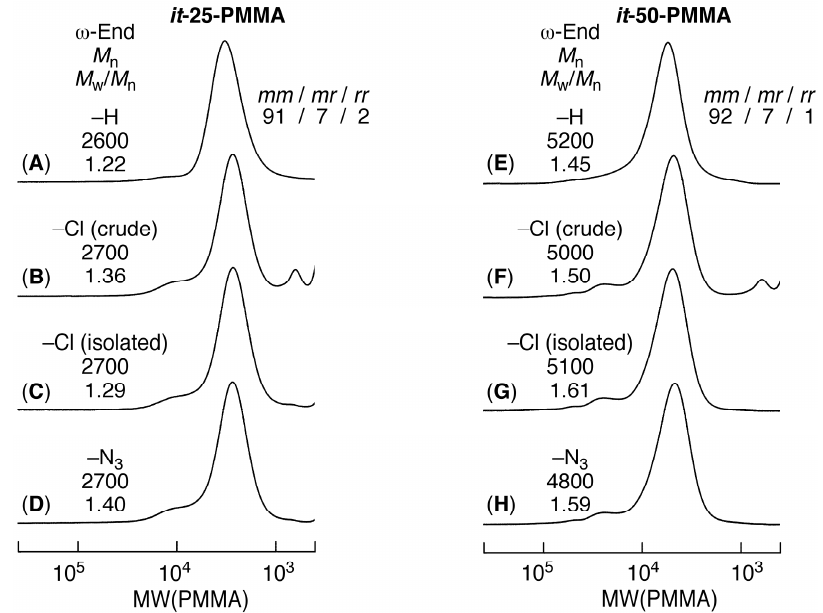
Figure 1. Size-exclusion chromatography (SEC) curves of a series of it - poly(methyl methacrylate)s (PMMAs) (( A – D ): it -25, ( E – H ): it -50) obtained in isotactic anionic polymerization of Methyl methacrylate (MMA) with t -BuMgBr in toluene at − 78 °C and subsequent procedures: ( A , E ) Quenching the polymerization ([M] 0 /[ t -BuMgBr] 0 = 1350/54 or 1350/27 mM) with acidic methanol; ( B , F ) Quenching the polymerization with CCl 4 /DBU ([M] 0 /[ t -BuMgBr] 0 /[CCl 4 ] add /[DBU] add = 1350/54/2160/540 or 1350/27/1080/270 mM); ( C , G ) Reprecipitations; ( D , H ) Azidation with NaN 3 /CuCl/CuCl 2 /bpy in CH 3 CN/H 2 O = 9/1 at 40 °C ([—Cl] 0 /[NaN 3 ] 0 /[CuCl] 0 /[CuCl 2 ] 0 /[bpy] 0 = 10/100/6.5/4.3/22 mM).